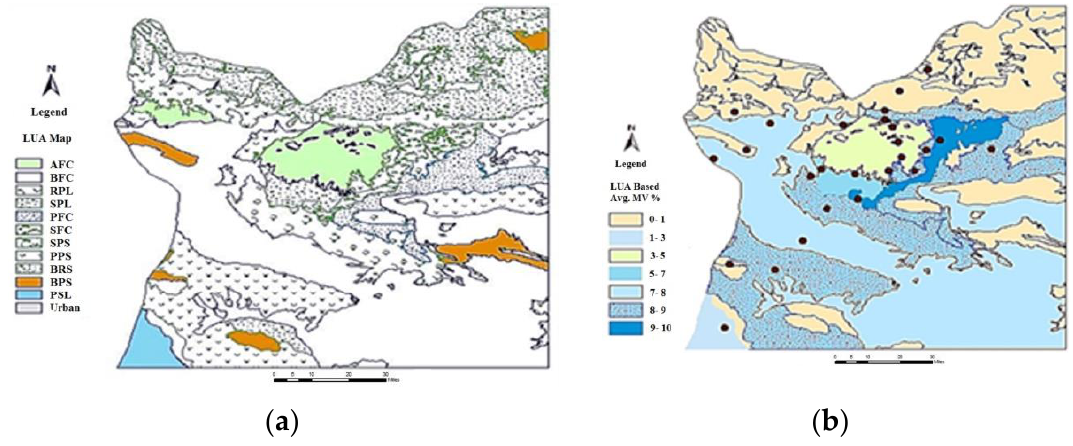
Figure 7. The LUA map ( a ) produced by a geospatial database and ( b ) the SM map based on LUA and sample point in ArcMap sample point in Table 3. Unit code descriptions of the land unit area map (Figure 7).